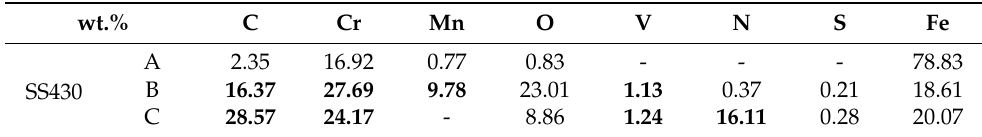
Table 9. EDS surface analysis (wt.%) of SS430 after the removal of the corrosion layer formed during the exposure for 30 days to SS1 cement extract solution.